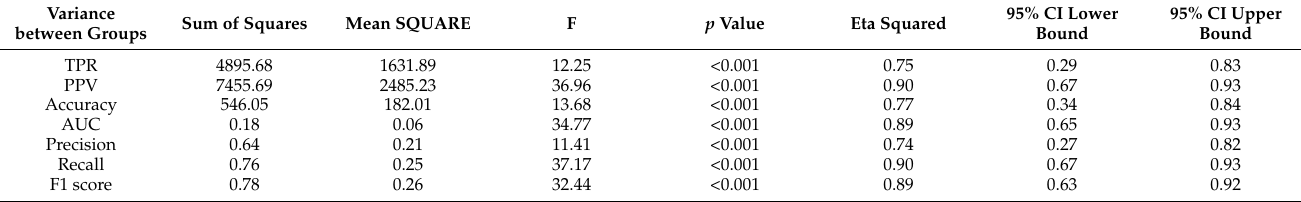
Table 5 legend: TPR—true positive rate; PPV—positive predictive value; AUC—area under the curve; CI— confidence interval. Tests used: ANOVA analysis with the Bonferroni post hoc